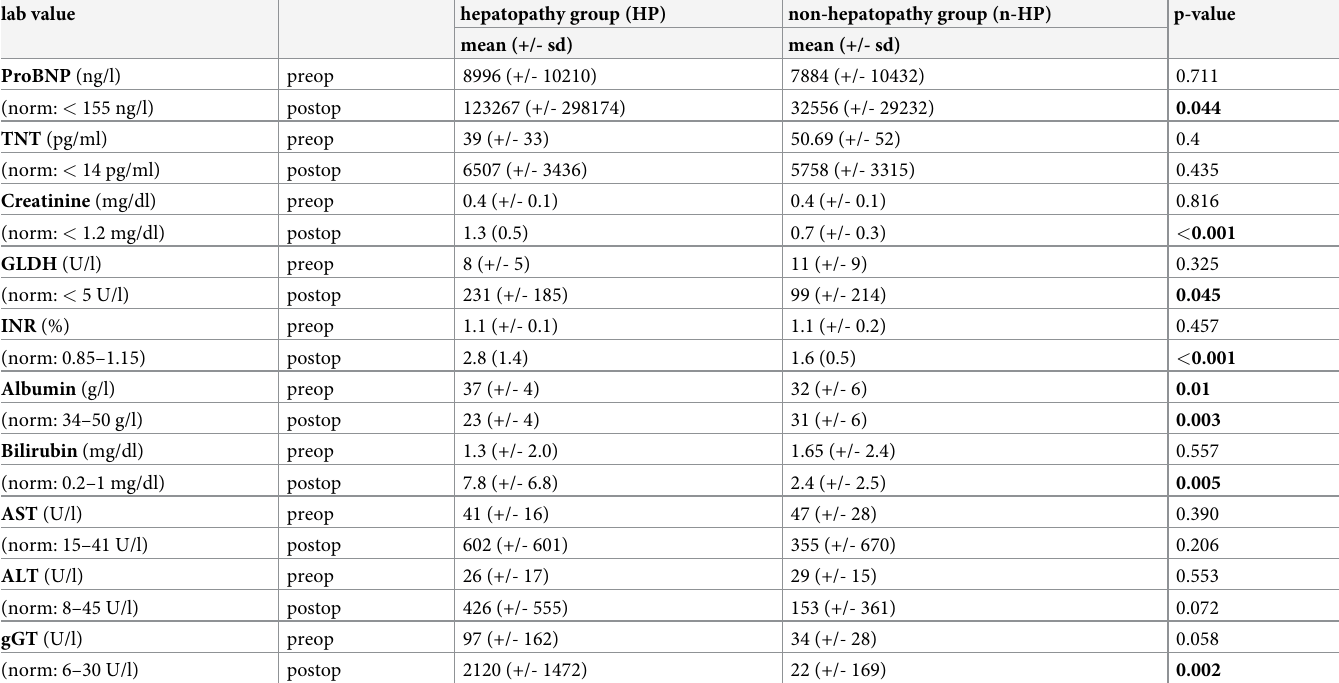
Table 4. Parameters of circulatory and hepatologic